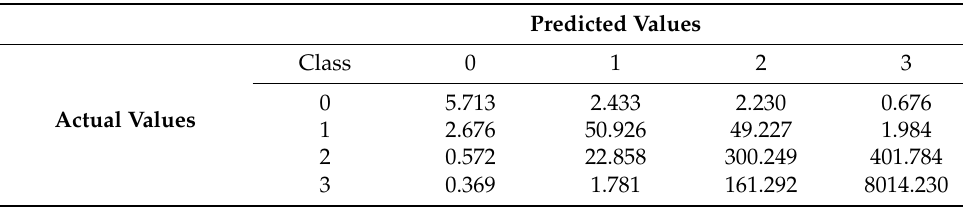
Table 7. Multi-class confusion matrix (average value) for the prediction of the popularity of cache